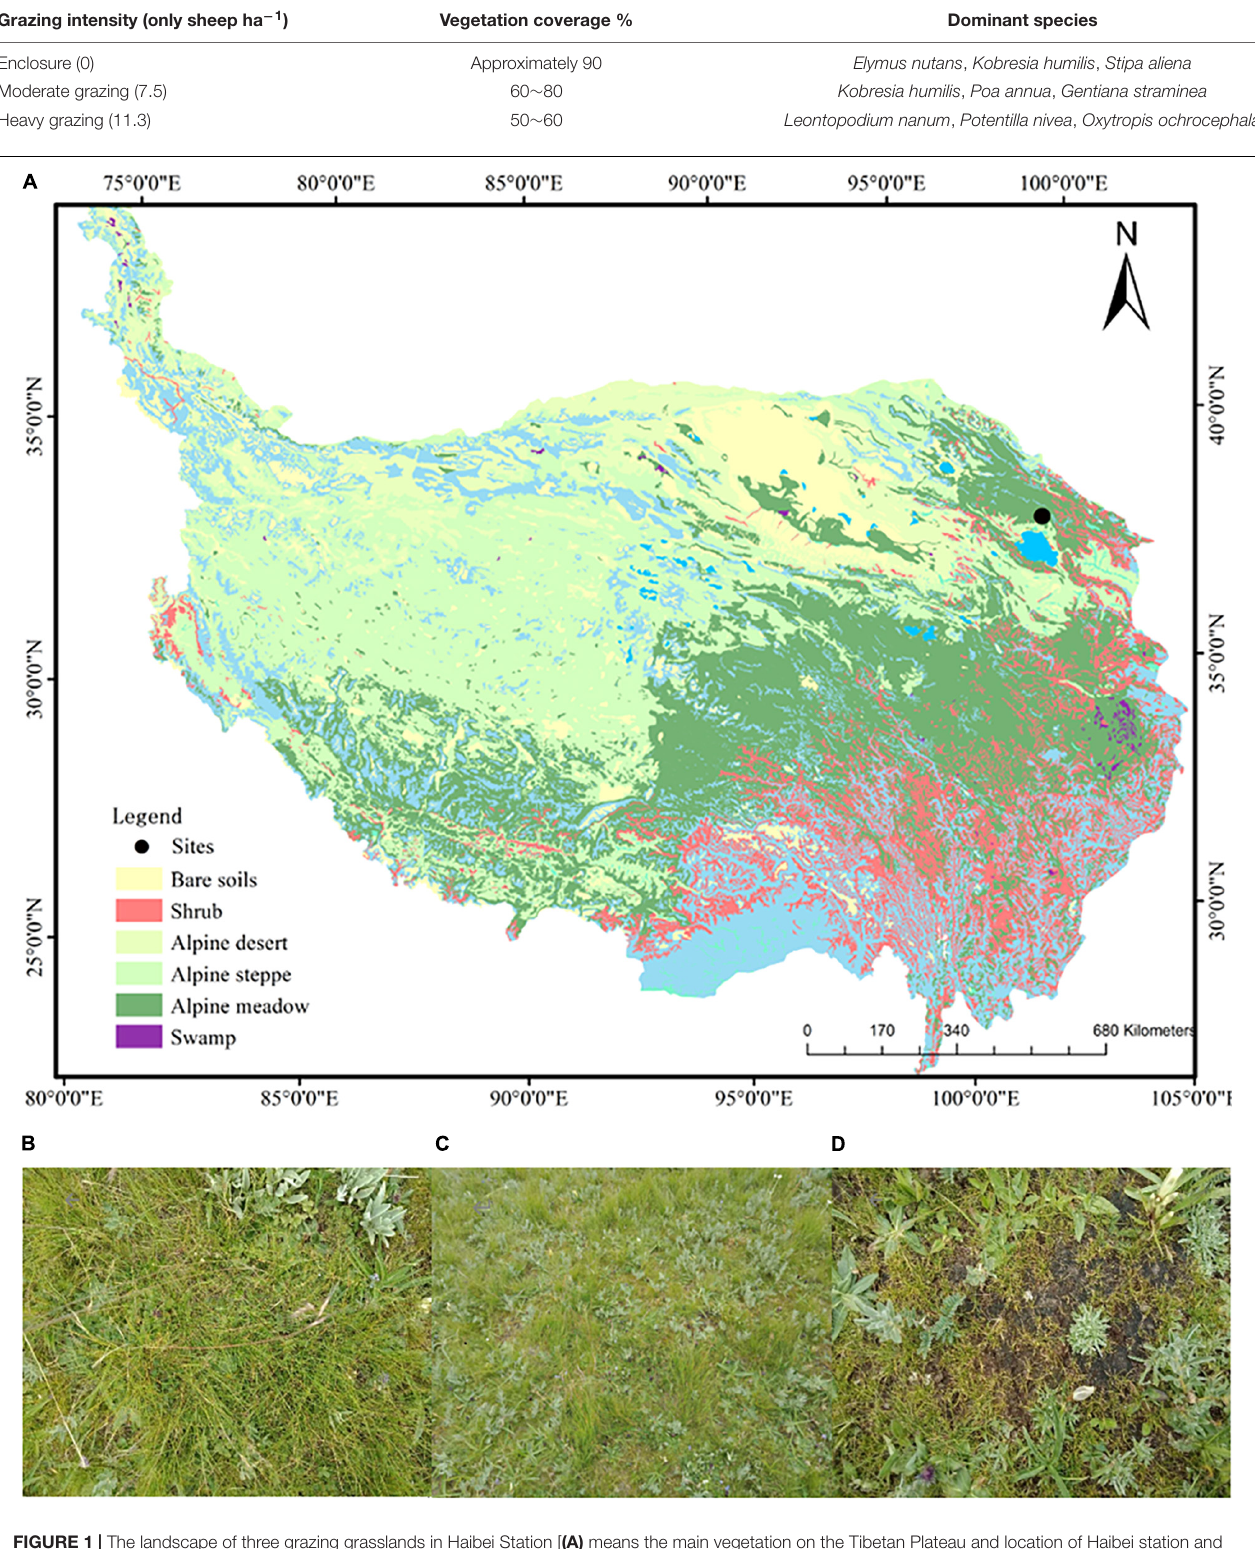
FIGURE 1 | The landscape of three grazing grasslands in Haibei Station [ (A) means the main vegetation on the Tibetan Plateau and location of Haibei station and (B–D) indicate the vegetation growth and its main species at 0, 7.5, and 11.3 sheep/ha].